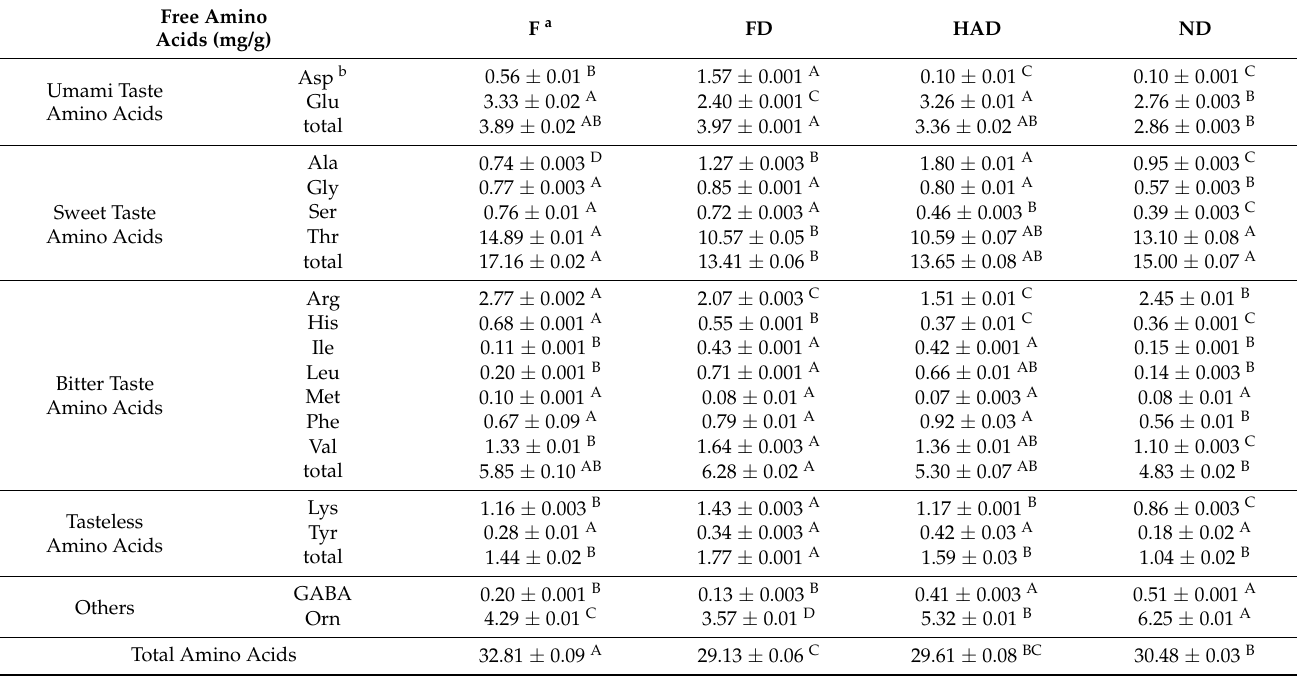
Table 3. The content of free amino acids in fresh and different dried L. edodes .